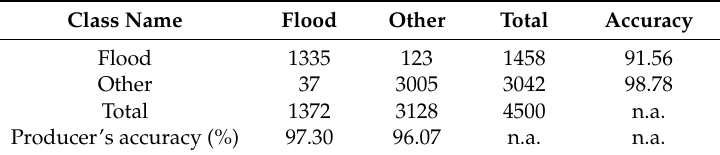
Table 1. Error matrix for the land cover map of 2017.